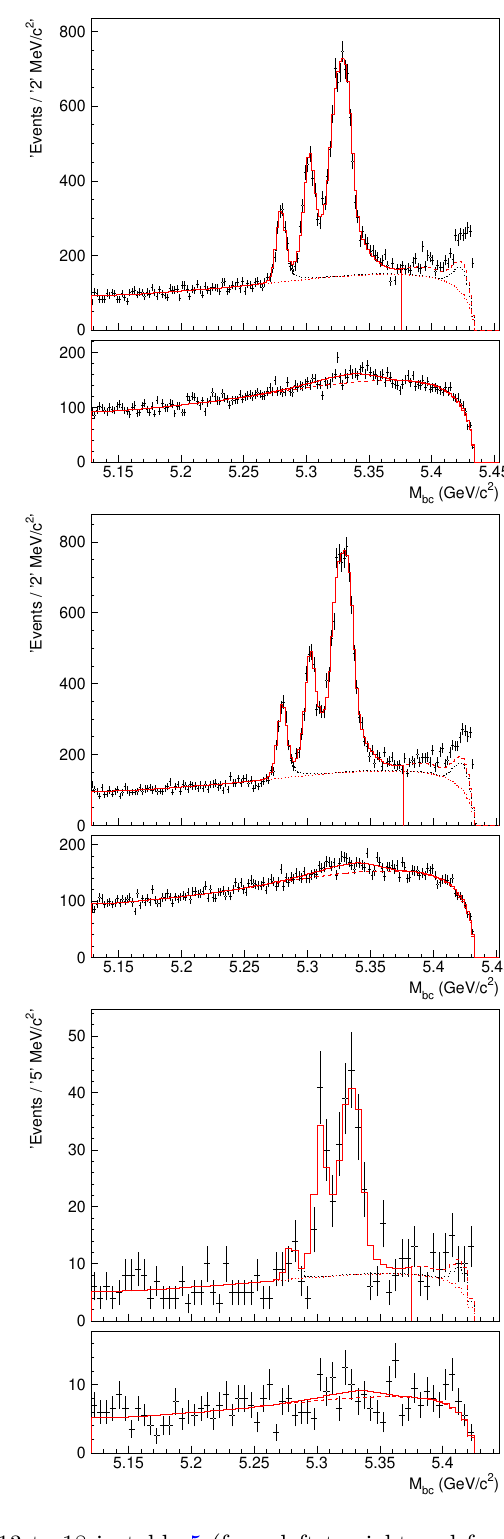
Figure 16 . The M bc distributions for the points 13 to 18 in table 5 (from left to right and from top to bottom). Legend is the same as in figure